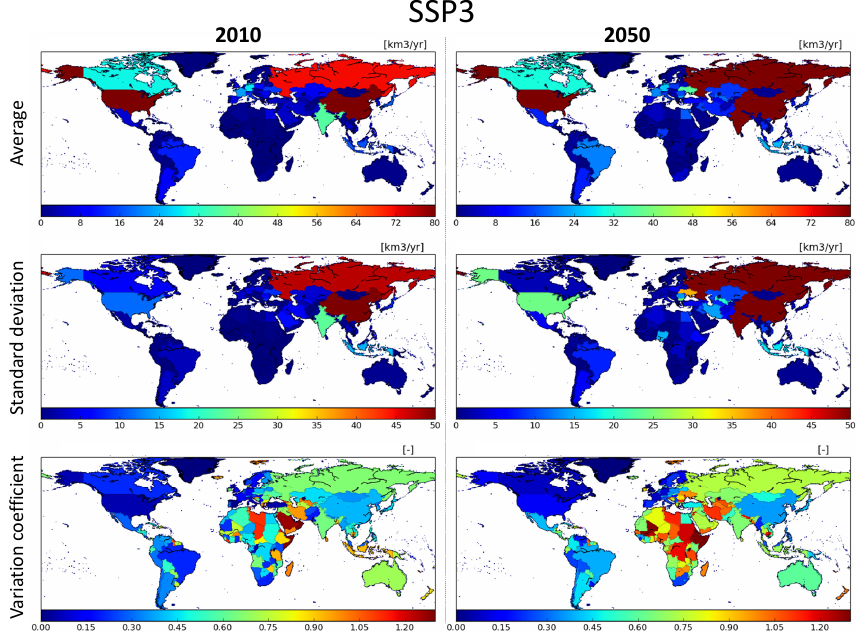
Figure A6. Global maps of projected industrial water withdrawals calculated by the global water models H08, PCR-GLOBWB, and Wa- terGAP for the years 2010 and 2050, respectively, under the SSP3 scenario. Avr, Std, and Std/Avr denote average, standard deviation, and coefficient of